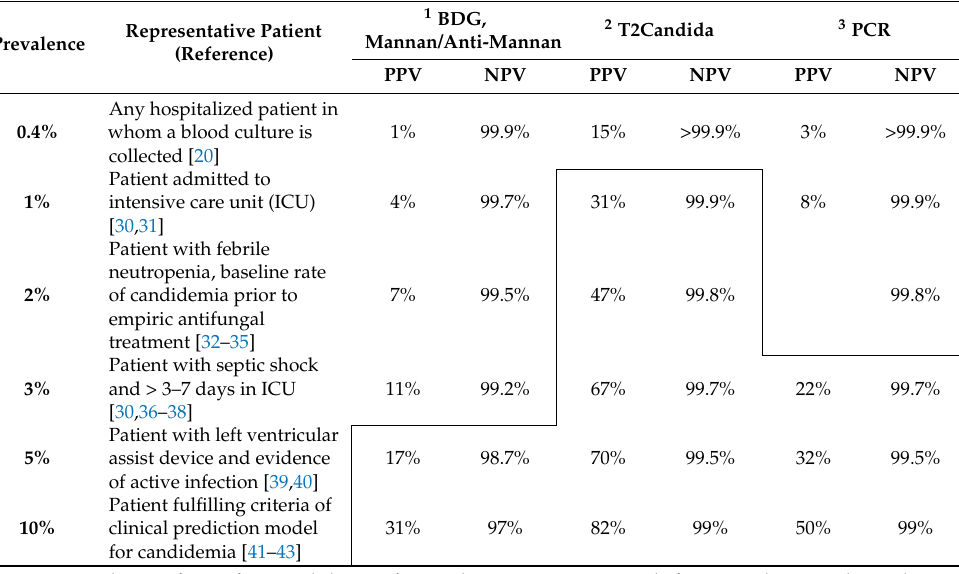
Table 1. Prevalence of candidemia in different populations, and anticipated PPVs and NPVs of non-culture